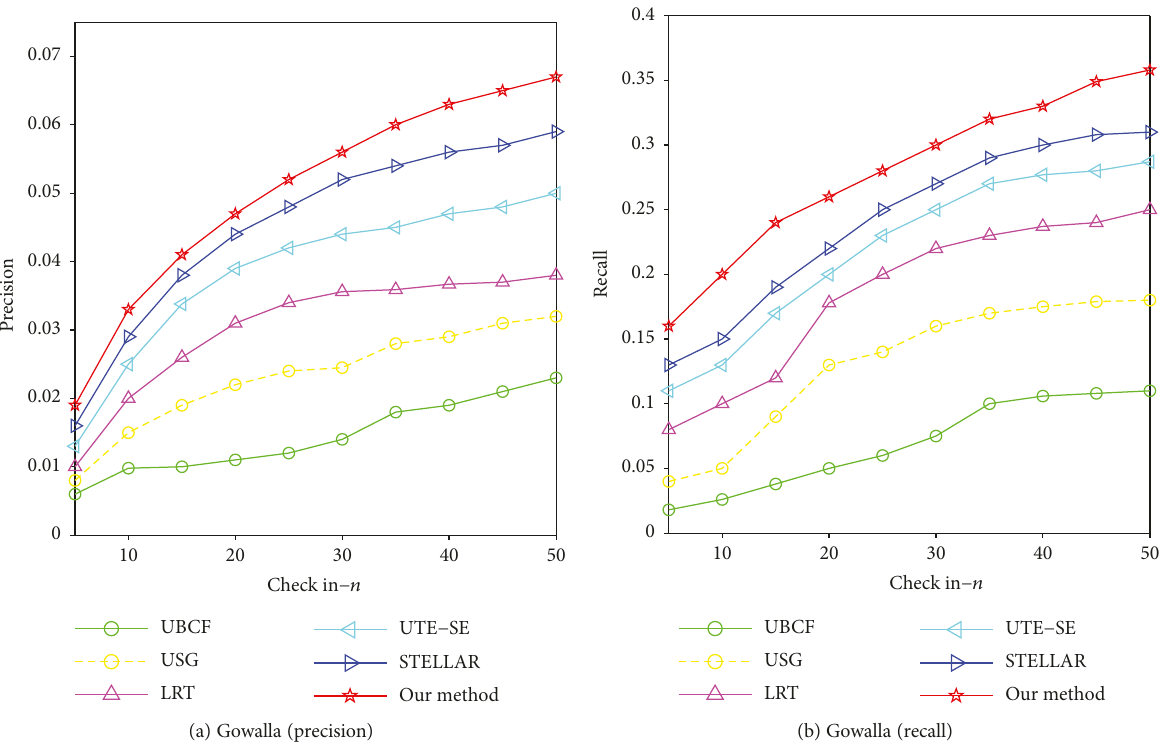
Figure 8: E ff ect of numbers of check-in locations of users on the Gowalla Dataset.